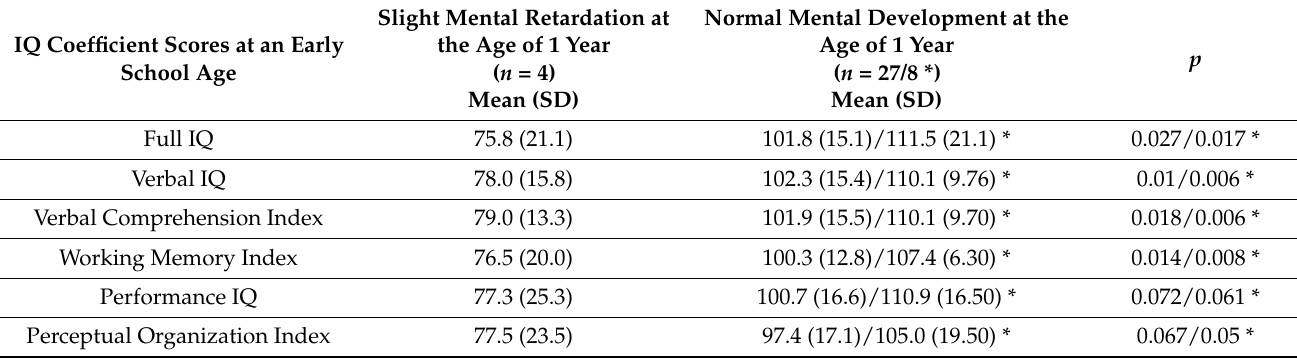
Table 6. Mean IQ coefficient scores at an early school age in children with and without mental retardation at the age of 1